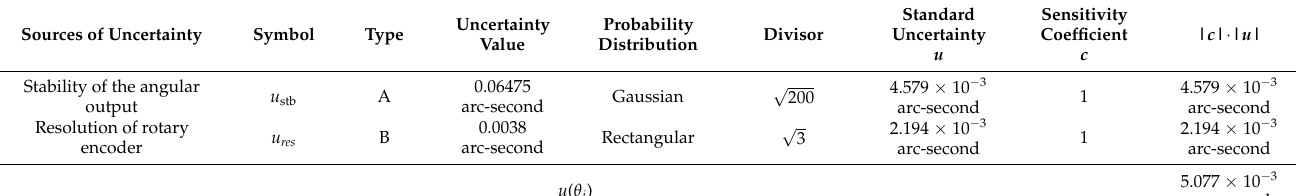
(d) Uncertainty of the light wavelength detected at each Littrow configuration ( u ( λ i )) In the proposed method, the light wavelength λ pos_ i or λ neg_ i for pitch measurement is evaluated based on Equation (7) as the peak wavelength of the obtained spectrum. Therefore, light intensity fluctuation at each light wavelength and the uncertainty of the reading in the optical spectrum analyzer could contribute to the uncertainty u ( λ i ) of the light wavelength detected at each Littrow configuration. In this study, a value (7.10 × 10 − 4 nm) from the previous work by the authors’ team [24] was employed as u ( λ i ). (e) Uncertainty of the refractive index in air nair ( u ( nair